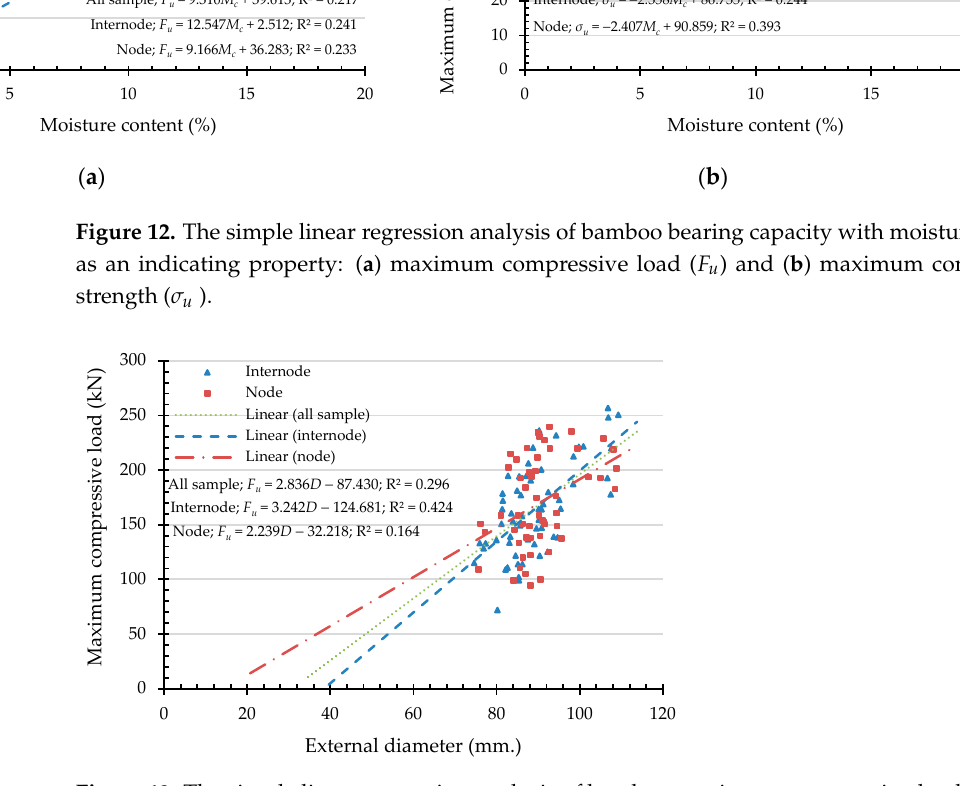
Figure 14. The simple linear regression analysis of bamboo maximum compressive load ( u F ) with linear mass at 12% c M as an indicating property. Figure 15. The simple linear regression analysis of bamboo maximum compressive strength ( u σ ) with linear mass at 12% c M as an indicating property.